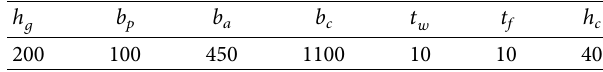
GFRP straight web Figure 2: Comparison between GFRP straight web and GFRP corrugated web. Table 1: Geometric parameters of the hybrid girder (mm). h